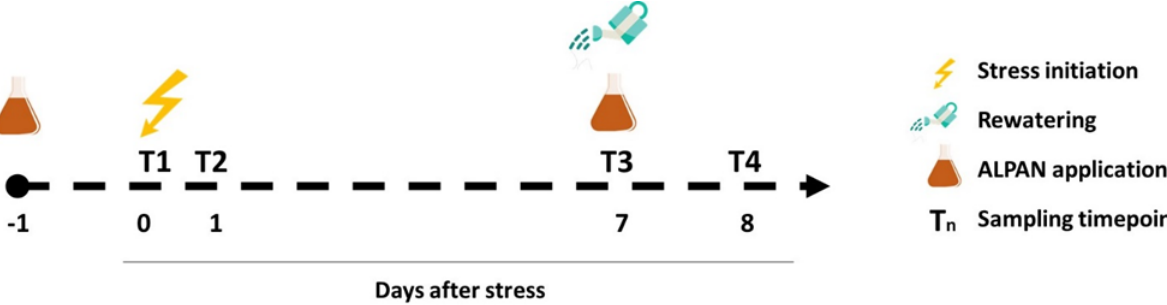
Figure 11. Schematic representation of the experimental design with the sampling time points for molecular and physiological analysis. Four biological replicates in each experimental group at each timepoint.